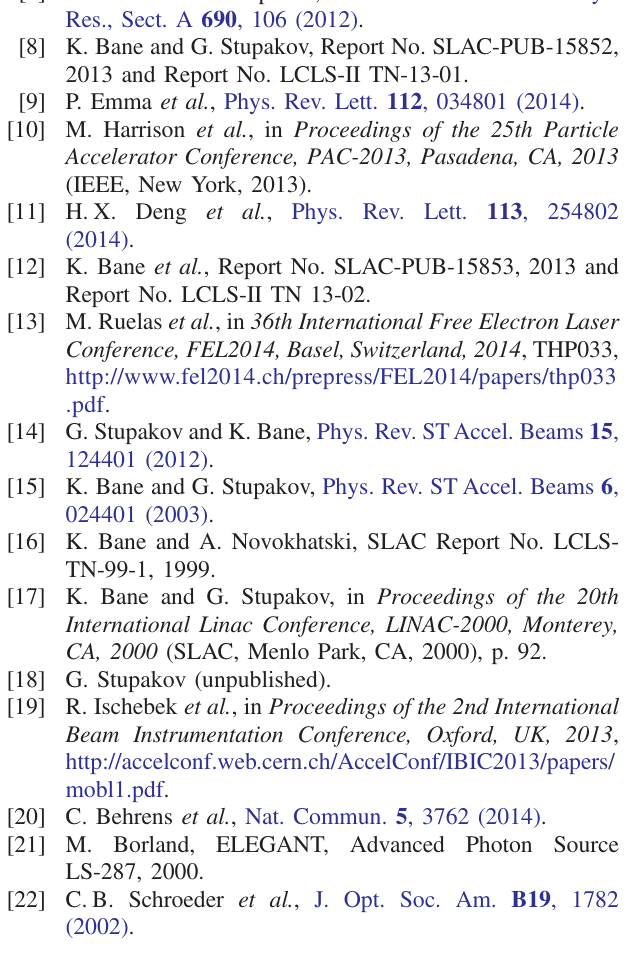
Fig. 18 by þ 40 μ m to cancel the dipole wakefield, which